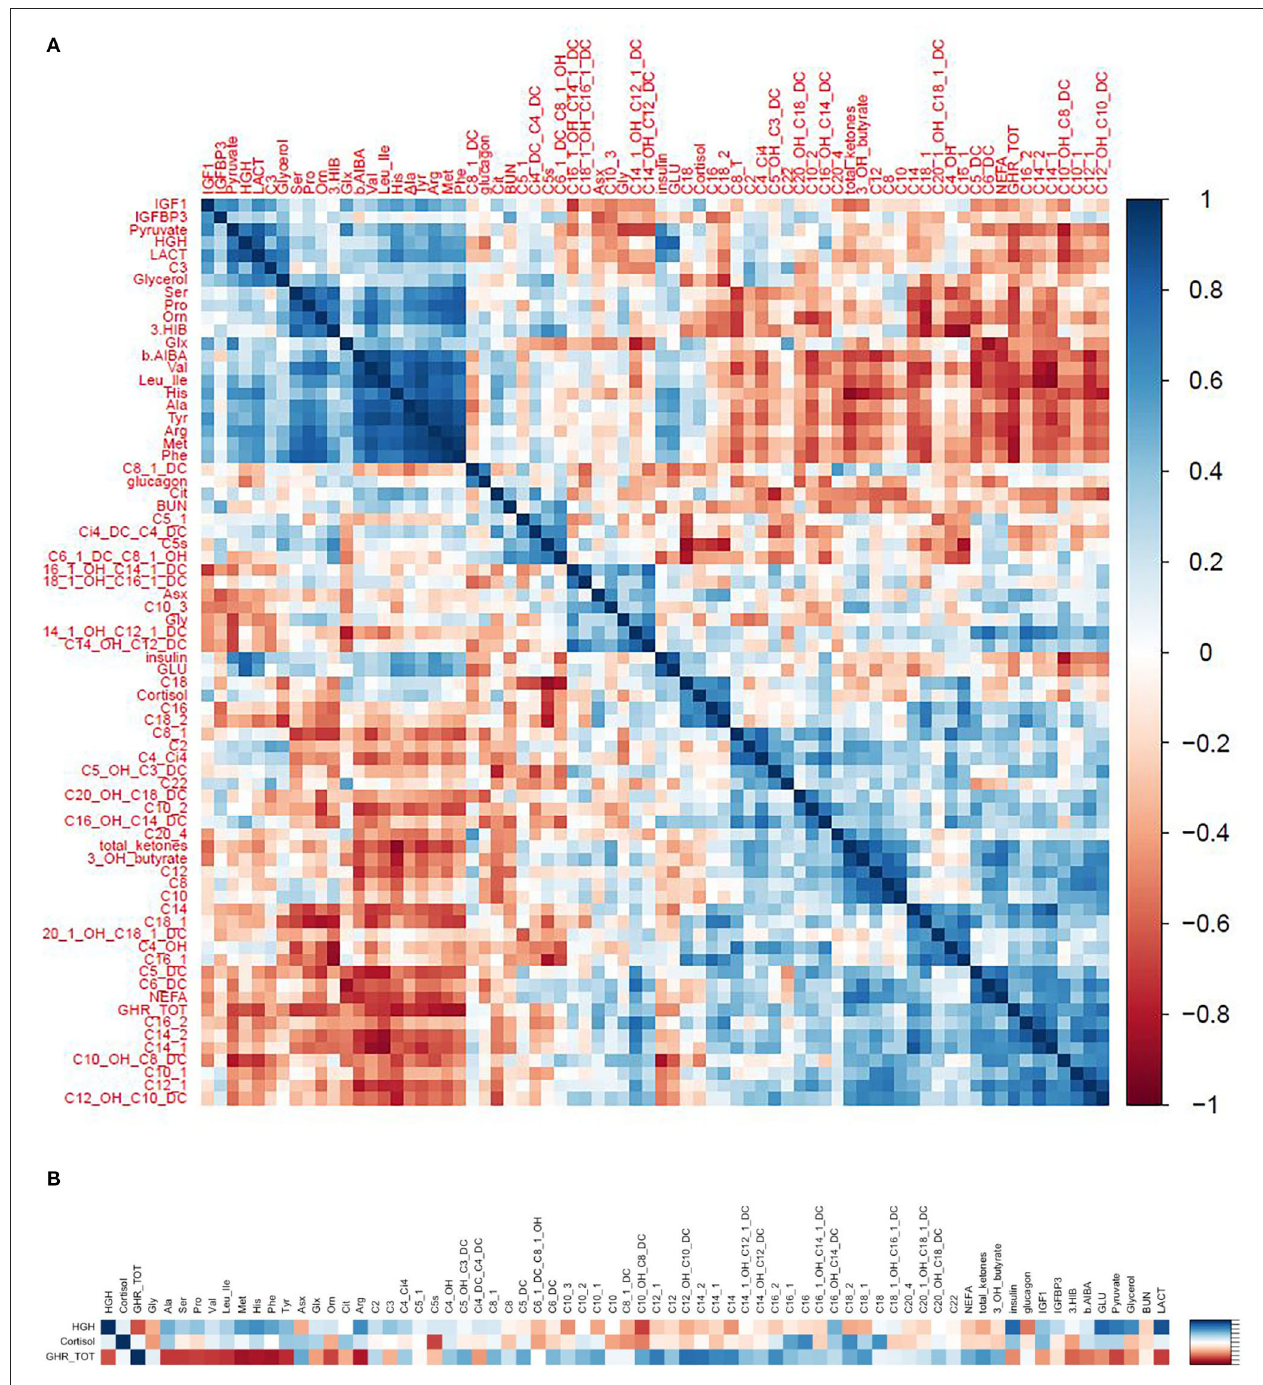
FIGURE 10 | (A) Correlograms depicting the correlations (spearman rho) between changes in hormones and metabolites in response to exercise. (B) A focused view showing just the correlations between key hormones of interest (GH, ghrelin, and cortisol) and the most significant metabolic adaptions in response to exercise.